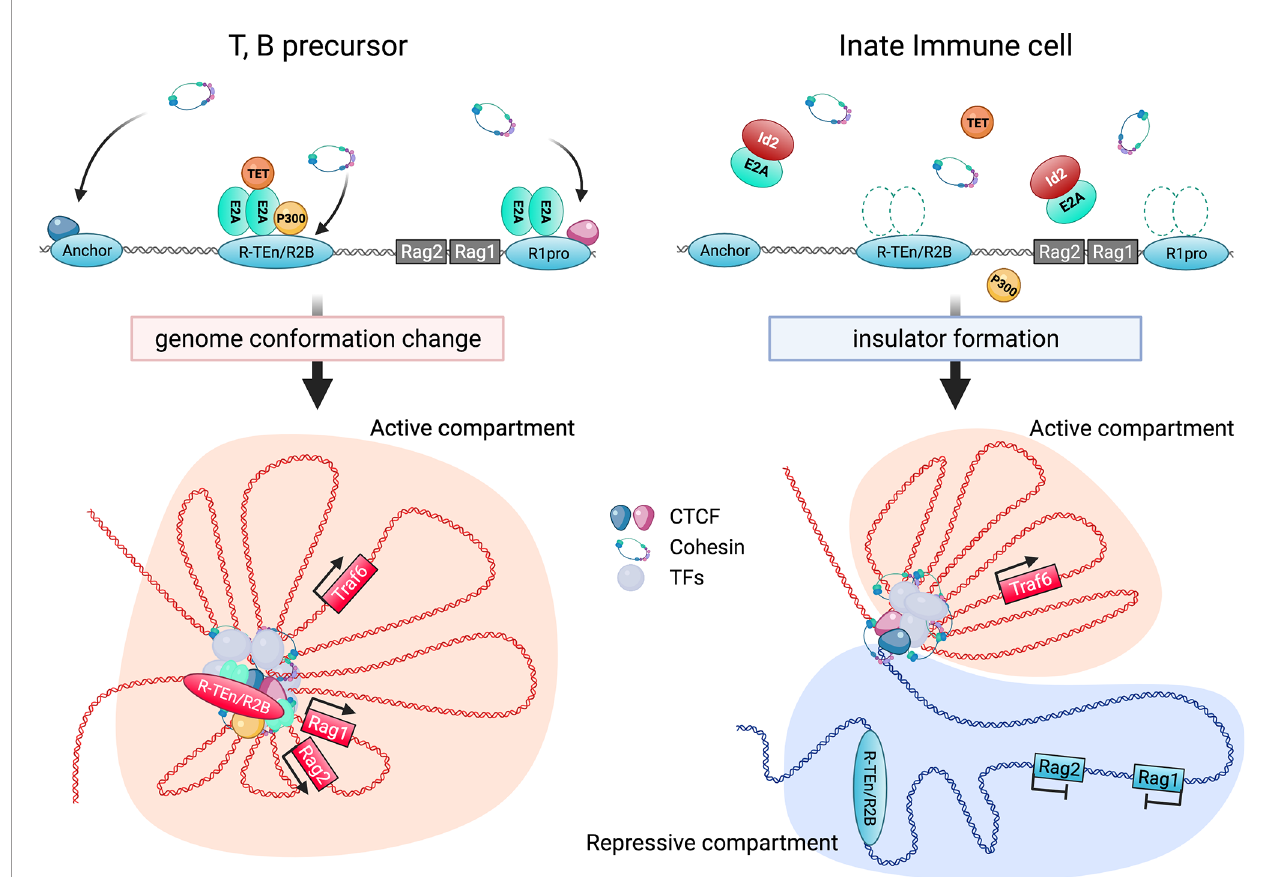
FIGURE 2 | Regulation of Rag gene locus by E2A and cis-regulatory elements. E2A binding to the speci fi c enhancer ( R-TEn and R2B ) and R1pro regions induces the genome conformation changes to form adaptive lymphocyte-speci fi c SE through the recruitment of P300, TET, and NIPBL-cohesin complex (left; developing T and B cells). In contrast, Id2 prevents E2A/E proteins from binding to these regulatory regions, leading to the insulator formation to sequester the Rag genes in repressive chromatin compartment in innate immune cells (right; macrophage etc). This fi gure was created with